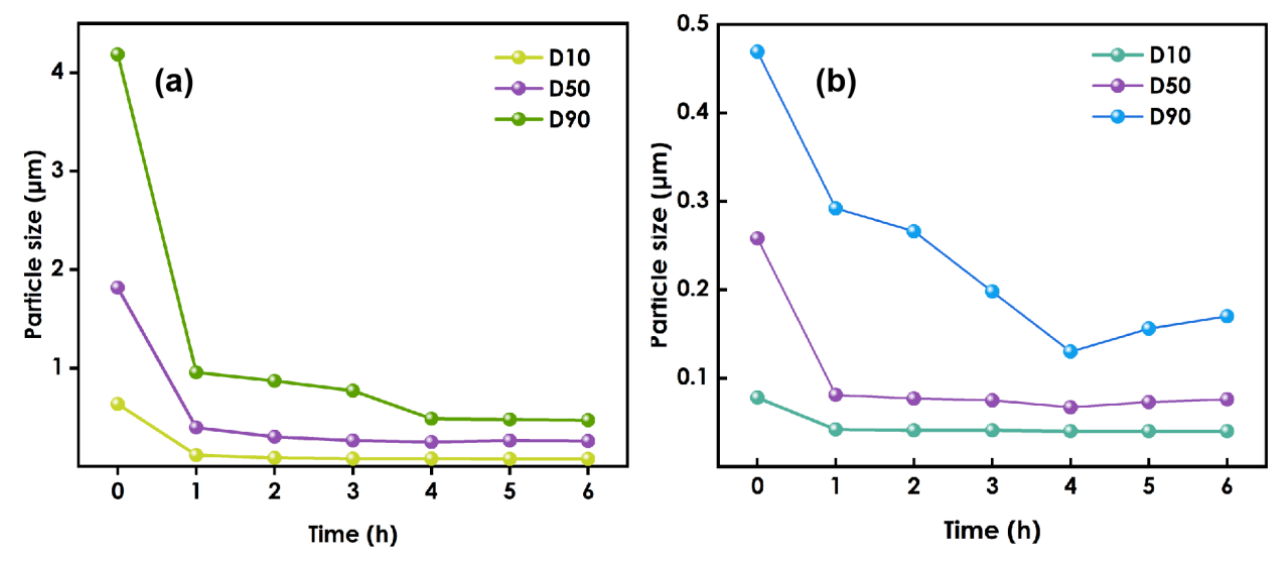
Figure 1. The figure of particle size variation:( a ) used 0.8 mm zirconium beads, ( b ) used 0.1 mm zirconium beads